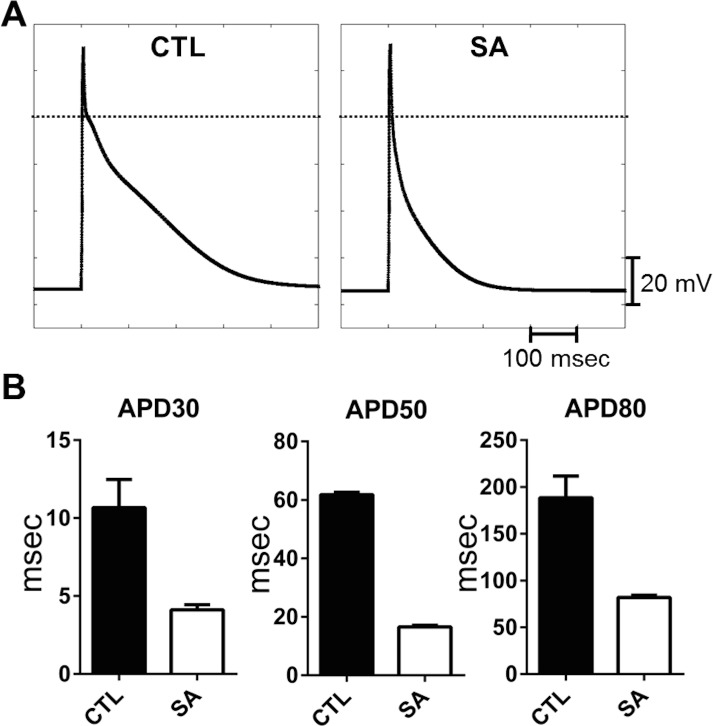
Human atrial action potential model simulation of stearic acid effects on ionic currents in isolated atrial cells.Panel A: Model generated action potential under control conditions (left) and following SA-induced changes in ionic currents (see text for details) (right). Panel B: Measurements of APD30, 50 & 80 from ten consecutive action potential simulations under control (CTL, black) and with SA treatment (white).